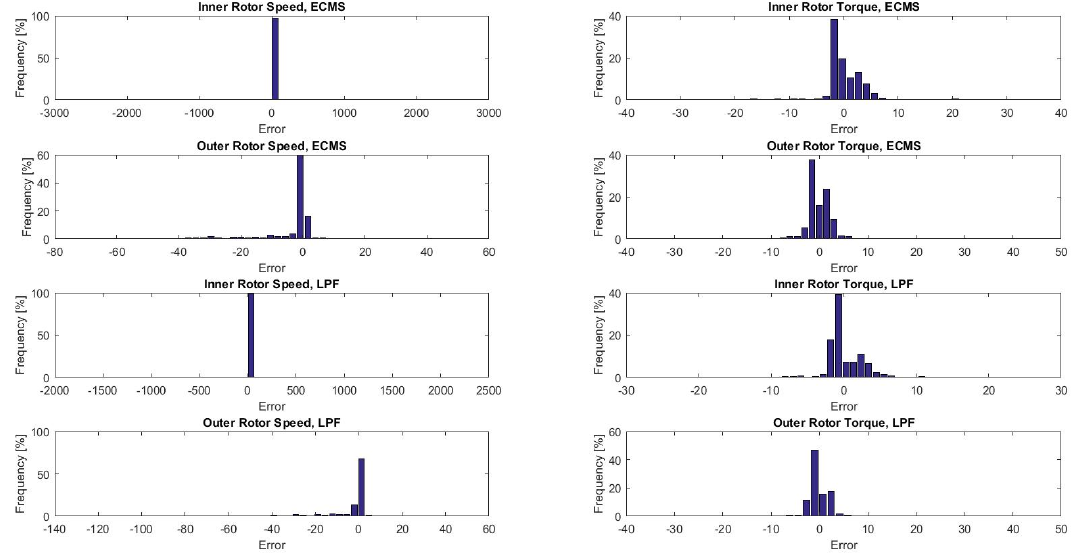
Figure 25. HiL vs. MiL error histograms.